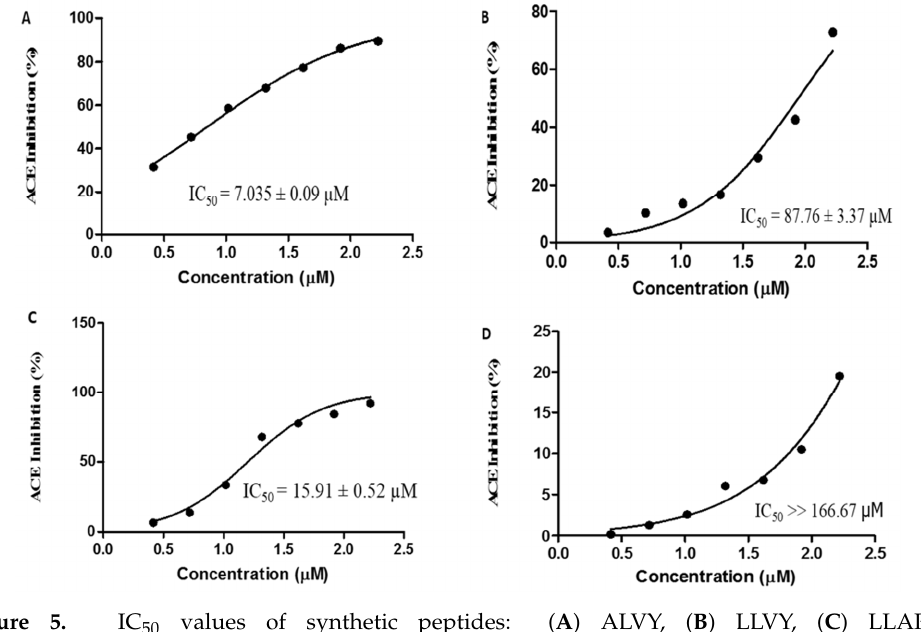
Figure 5. IC 50 values of synthetic peptides: ( A ) ALVY, ( B ) LLVY, ( C ) LLAPHY, and ( D ) LSTSTDVR